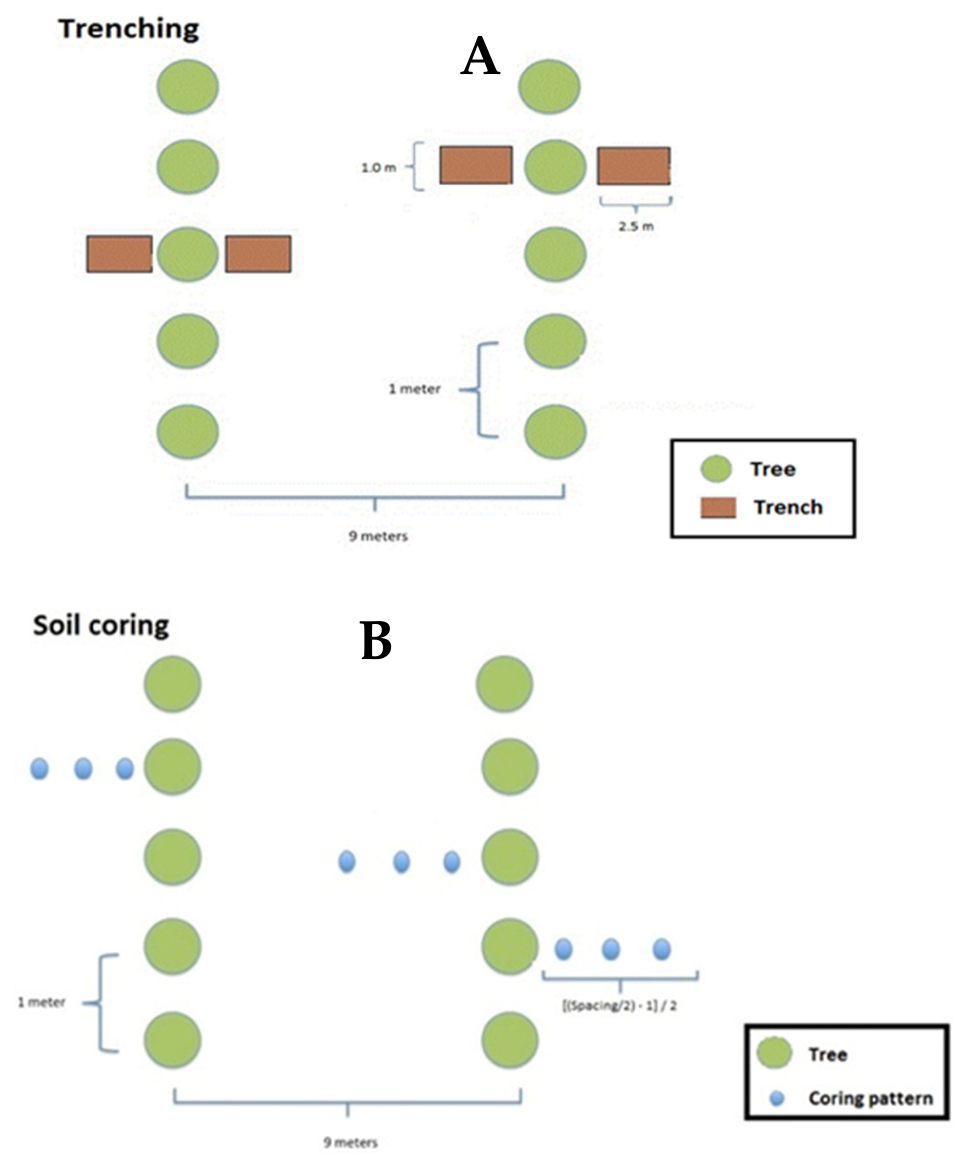
Figure 2. Illustration of the trenching procedure in 9 m × 1 m plantations ( A ) and soil coring procedure ( B ).